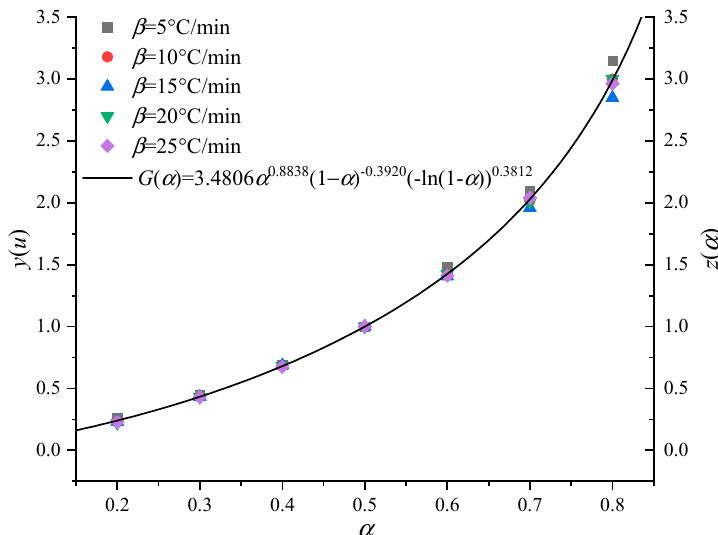
Figure 6. Relationship between activation energy and conversion rate.